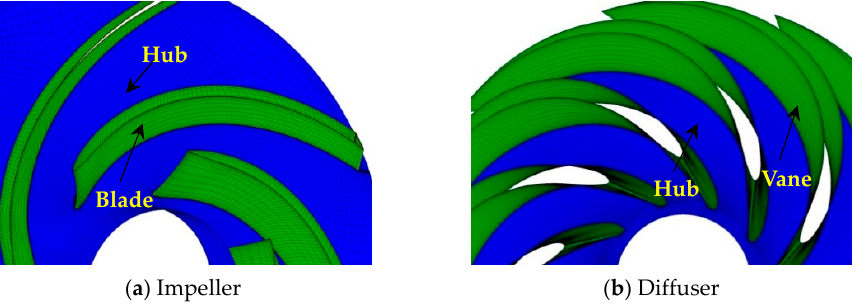
Figure 2. Grids of the impeller and the diffuser.